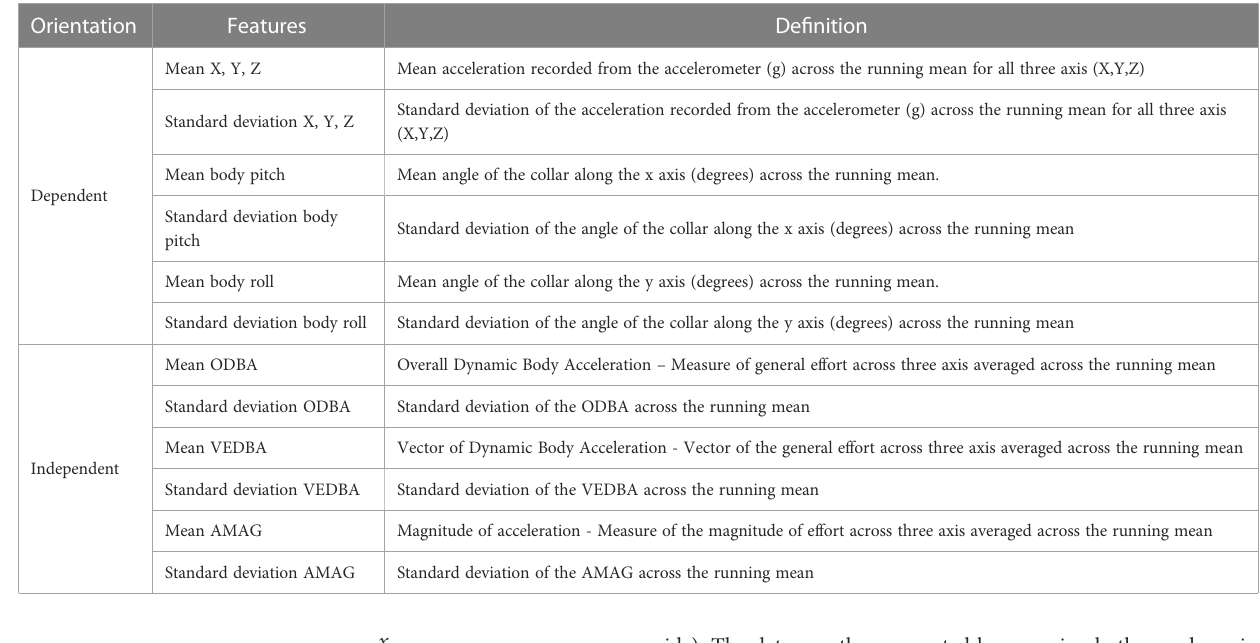
TABLE 1 Overview of the features used in the models: orientation dependent (three axis, body pitch, and body) and orientation independent (overall dynamic body acceleration (ODBA), vector of dynamic body acceleration (VEDBA), and magnitude of acceleration (AMAG)). Orientation